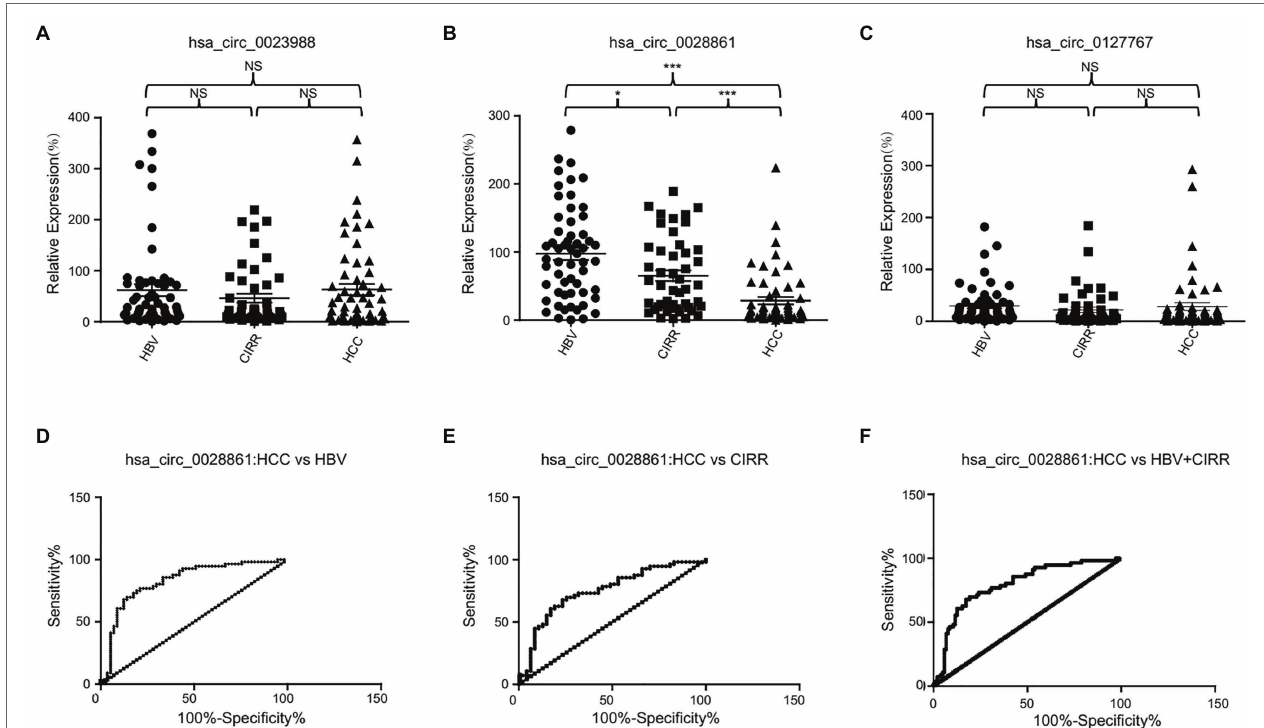
FIGURE 3 | The diagnostic performance of hsa_circ_0028861. (A–C) The expression profile of serum exosomal hsa_circ_0023988 (A) , hsa_circ_0028861 (B) and hsa_circ_0127767 (C) in chronic HBV, cirrhosis, and HCC patients. (D–F) The ROC curves of hsa_circ_0028861 for discriminating HCC from chronic HBV (D) , cirrhosis (E) or the combination of chronic HBV and cirrhosis patients (F) , respectively. HBV, hepatitis B virus; CIRR, cirrhosis; HCC, hepatocellular cancer; ROC, receiver operating characteristic; and NS, not significant. * p < 0.05; *** p < 0.001.